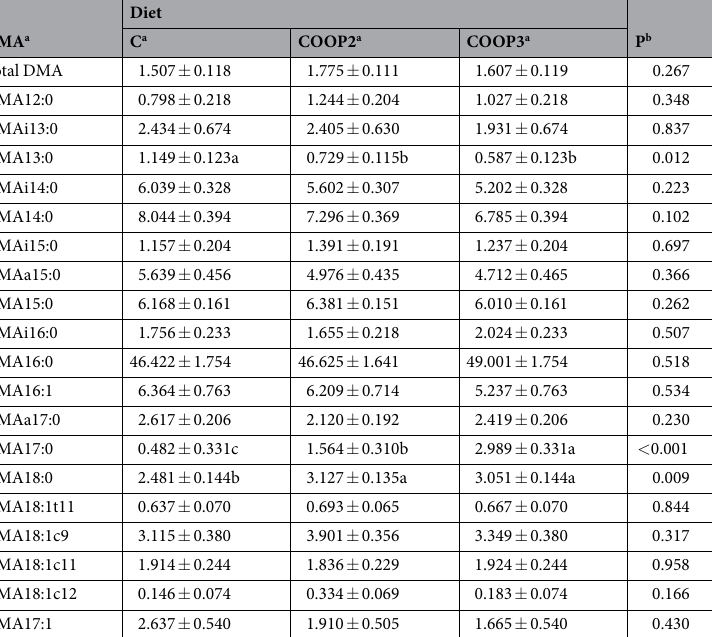
Table 2. Total DMA a (mg/g dry matter ± SEM a ) and DMA a composition (g/100 g of total DMA a ± SEM a ) of rumen liquor. a Acronyms used in this table: DMA (dimethyl acetal), C (control diet), COOP2 (control diet added with olive oil pomace extracted with a two-phase procedure), COOP3 (control diet added with olive oil pomace extracted with a three-phase procedure) and SEM (Standard Error Mean). b Probability of significant effect due to experimental diets; means within a row with different letters differ (P <